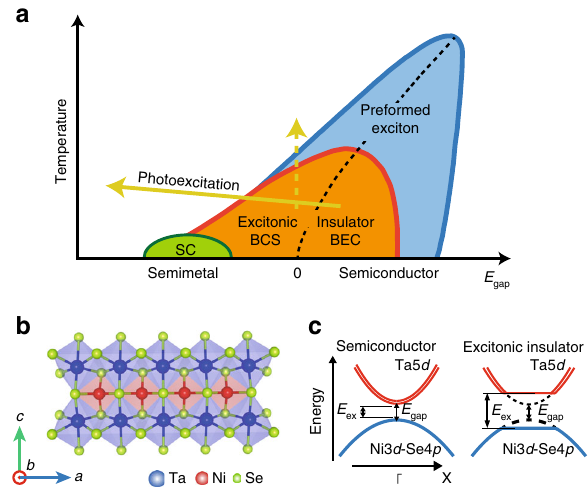
Fig. 1 Crystal and electronic structure of Ta 2 NiSe 5 and phase diagram of excitonic insulators. a Phase diagram of excitonic insulators. The solid arrow indicates the pathway for the photo-induced phase transition proposed in this study and the dashed arrow represents the effect of increasing the temperature. b Crystal structure of Ta 2 NiSe 5 . A quasi one- dimensional structure is formed by a single Ni chain and two Ta chains along the a -axis. c Schematic of the electronic structures of Ta 2 NiSe 5 along the Γ – X -direction in the semiconductor and excitonic insulator phases electron and a hole derived from doubly degenerate Ta 5 d bands and the